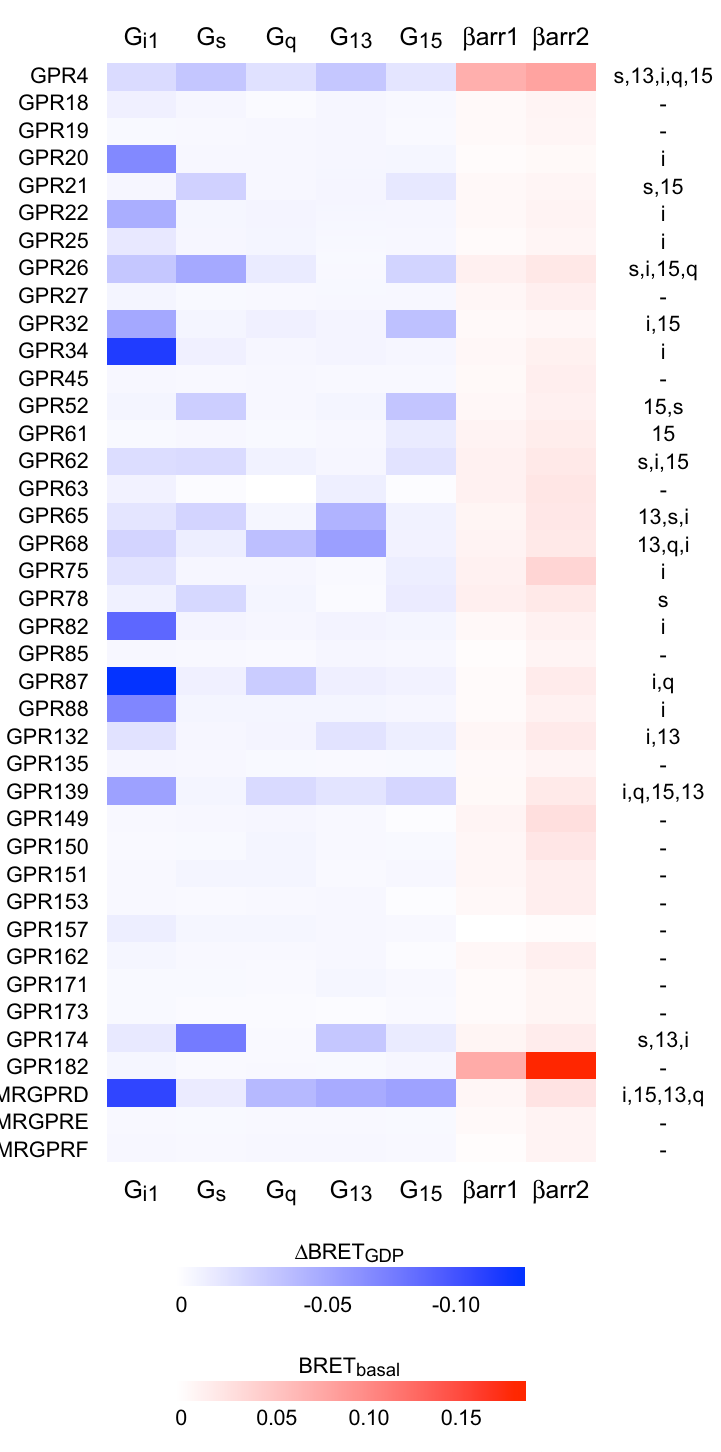
Fig 3. Constitutive G protein and β -arrestin coupling of understudied GPCRs. Heat maps representing the mean Δ BRET GDP for 200 receptor-G protein pairs (blue) and basal net BRET for 80 receptor- β -arrestin pairs (red). The righthand column indicates the G proteins for which Δ BRET GDP exceeded the determined threshold. Each cell represents the mean of three independent experiments performed in duplicate. Eight receptors that trafficked poorly to the plasma membrane are not shown here.